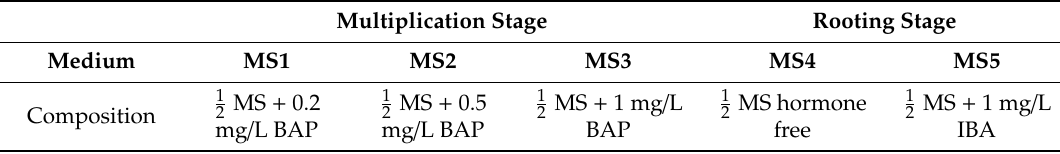
Table 1. Used for multiplication and rooting of P. tomentosa × P. fortunei hybrid. Half-strength MS (1 / 2 MS) supplemented with 2% sucrose, 0.7% agar, and di ff erent BAP (6-benzylaminopurine) concentrations, IBA (Indole-3-butyric acid) or hormone free